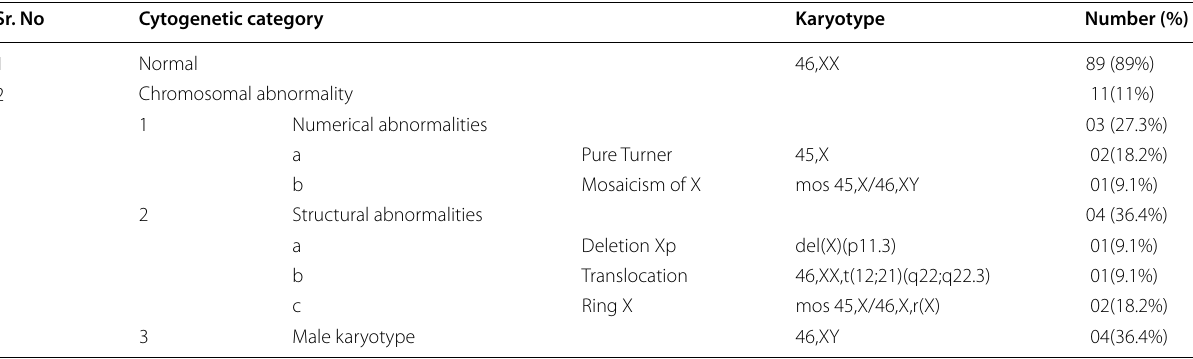
Table 1 Incidence and type of chromosomal abnormalities in PA Sr.